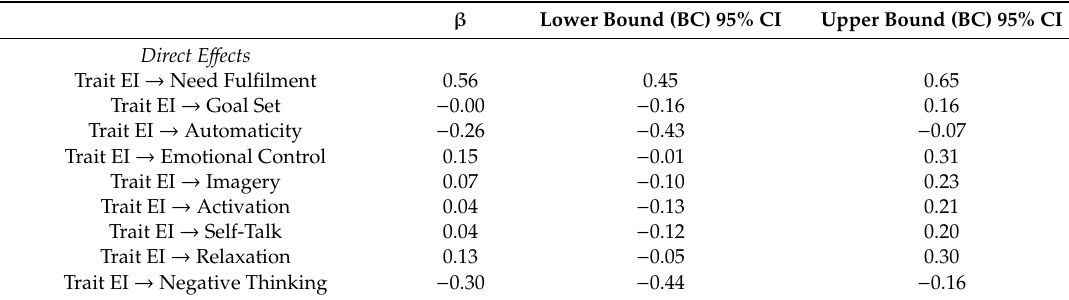
Table 4. Direct E ff ects, Indirect E ff ects, and Total E ff ects in competition